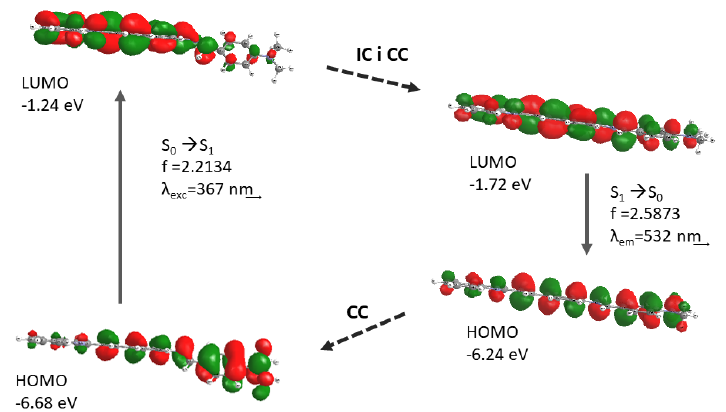
Figure 9. Geometry relaxation of compound 3a after photoexcitation. The more planar structure was the reason for the decrease in the energy gap between the HOMO and LUMO orbitals. CC—configuration change and IC—internal